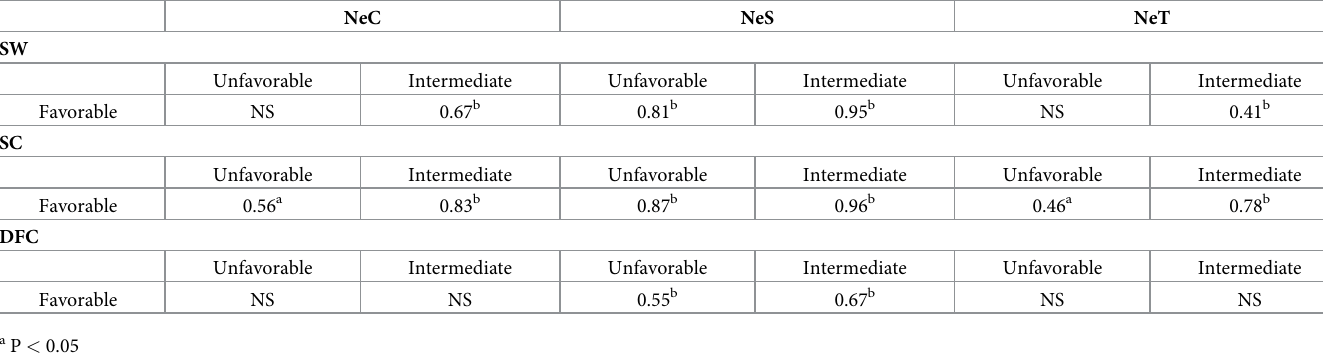
Table 2. Spearman correlations of the top 25% sires according to breeding values of Selection Weight (SW), Scrotal Circumference (SC), and Days at First Calving (DFC) in control (NeC), selection (NeS), and traditional (NeT) lines of Nellore cattle obtained using the reaction norm model under different environments (favor- able, intermediate, and